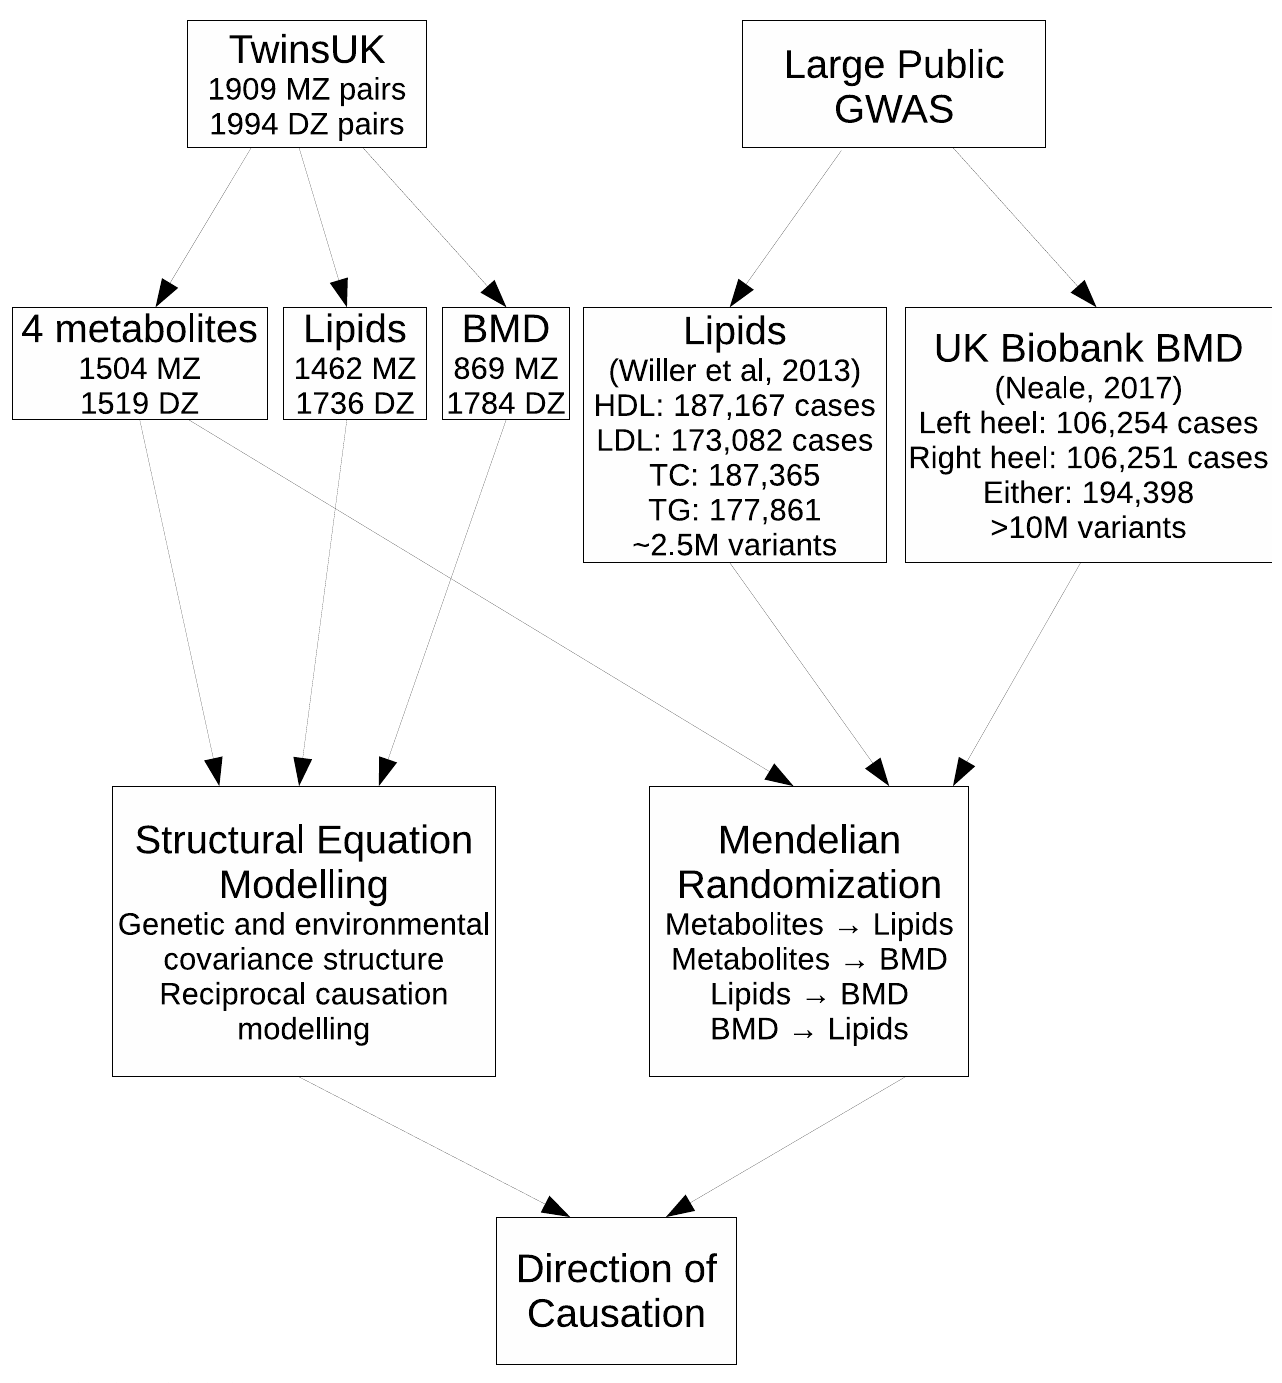
Fig 1. Flowchart of study